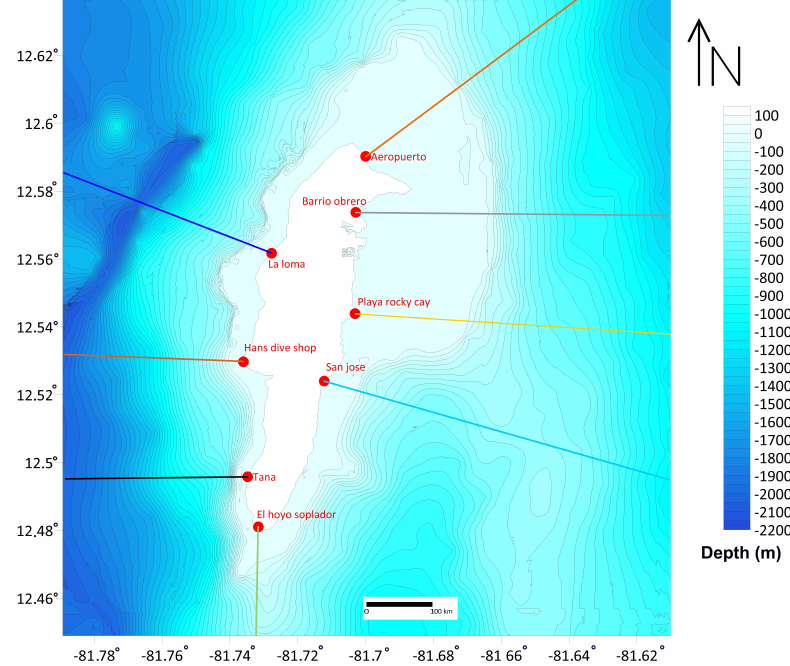
Figure 8. Location of the profiles in 7 points of San Andrés.